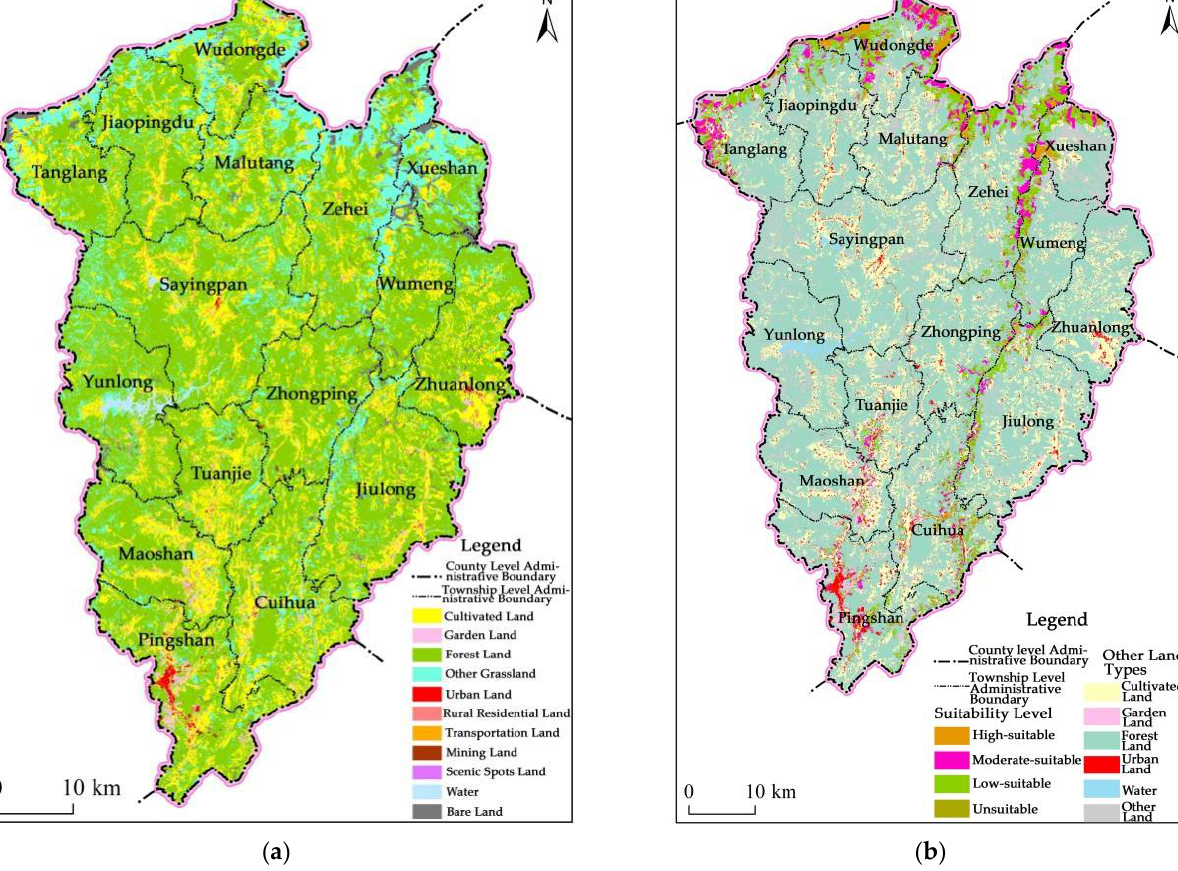
Figure 3. Results of land suitability evaluation of sorghum planting in Luquan County. ( a ) Present land-use map; ( b ) land suitability evaluation map. Table 6. Irrigated and dry land area of land suitability grade of sorghum planting in Jinsha River Basin of Luquan County (Unit: ha, %).